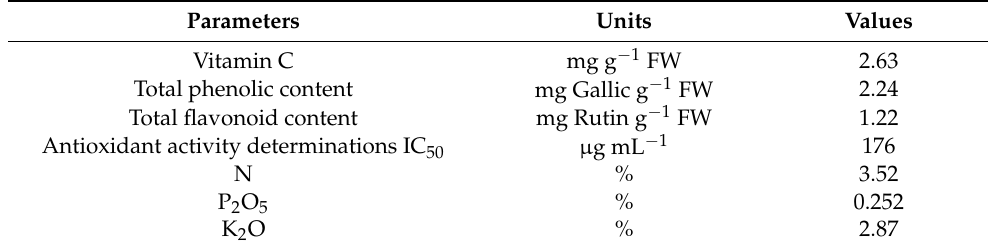
Table 3. Chemical characteristics of Moringa oleifera leaves extract used for the present study.